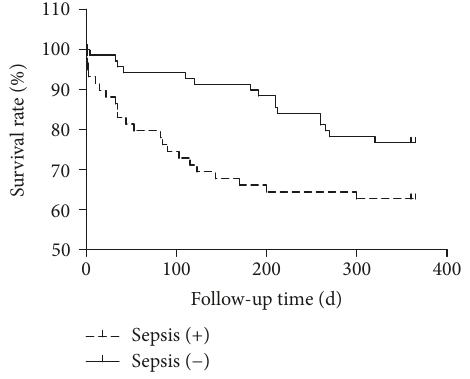
Figure 2: Survival rate and sepsis.